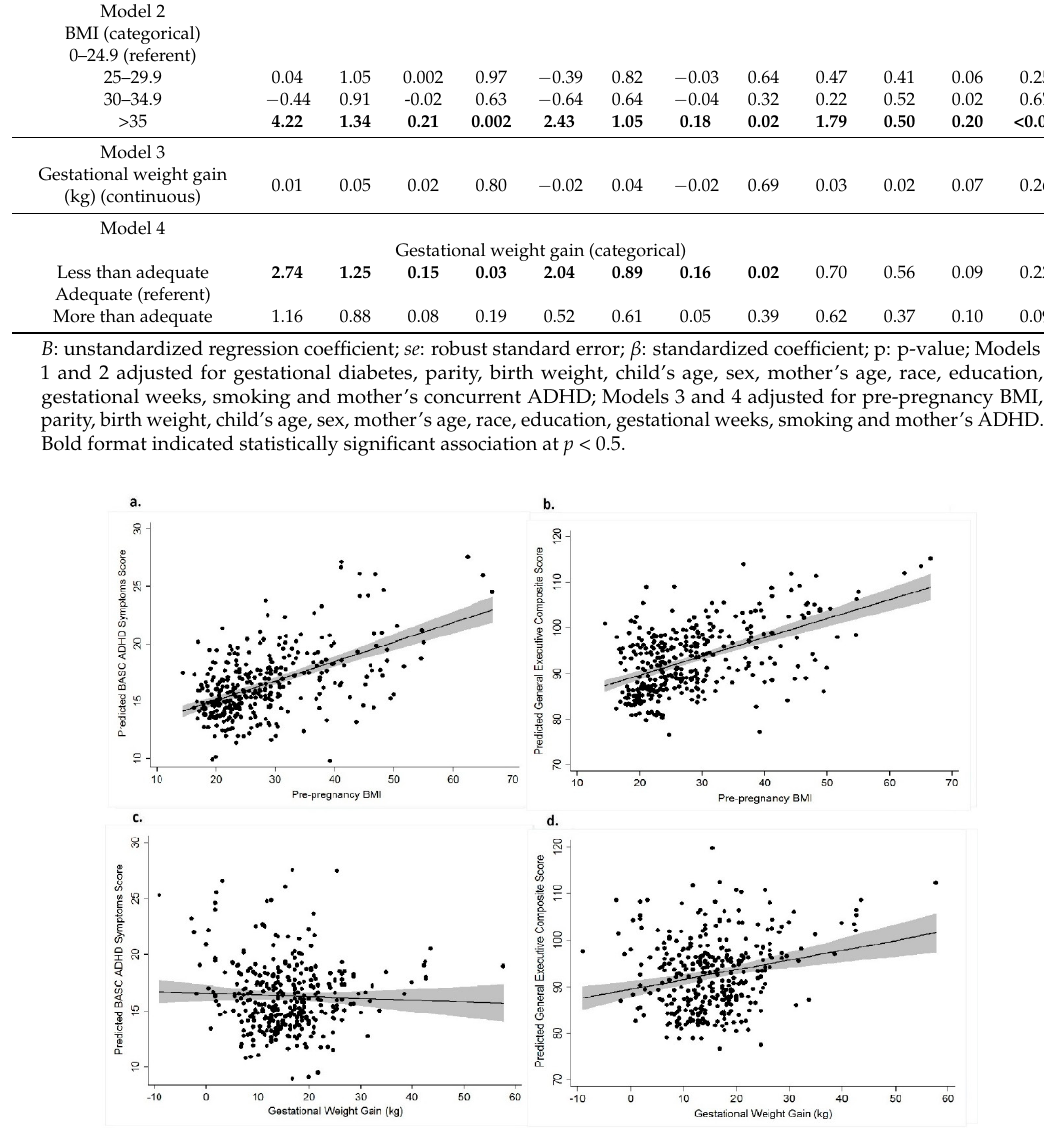
Figure 1. Fitted values (solid dots), fitted regression lines (solid lines) and 95% confidence limits (shaded area) for relationship between pre-pregnancy BMI and predicted BASC ADHD symptoms score ( a ), pre-pregnancy BMI and predicted BRIEF GEC score ( b ), gestational weight gain and predicted BASC ADHD symptoms score ( c ), and gestational weight gain and predicted BRIEF GEC score ( d ). Regression models adjusted for gestational diabetes, parity, birth weight, child’s age, sex, mother’s age, race, education, gestational weeks, smoking and mother’s ADHD for ( a ) and ( b ); and adjusted for pre-pregnancy BMI, gestational diabetes, parity, birth weight, child’s age, sex, mother’s age, race, education, gestational weeks, smoking and mother’s ADHD for ( c ) and ( d ).